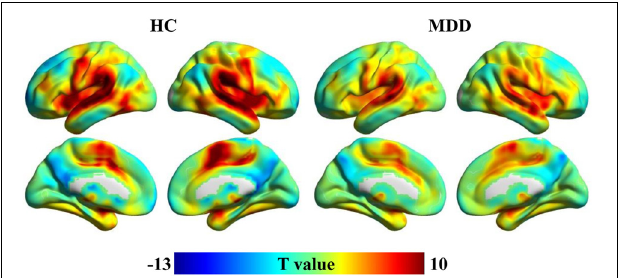
FIGURE 1 | One-sample t -tests were used to identify the distribution of weighted global brain connectivity (wGCB) in major depressive disorder (MDD) and healthy controls (HC). The high wGCB were primarily detected in the superior temporal gyrus, lateral occipital gyrus, fusiform gyrus, intraparietal sulcus, medial temporal lobe, middle cingulate cortex, caudate, medial frontal cortex, lateral prefrontal cortex, inferior frontal cortex, and insula.